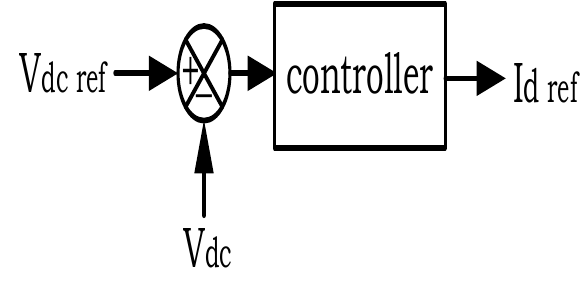
Figure 2. Distribution network diagram of the proposed system